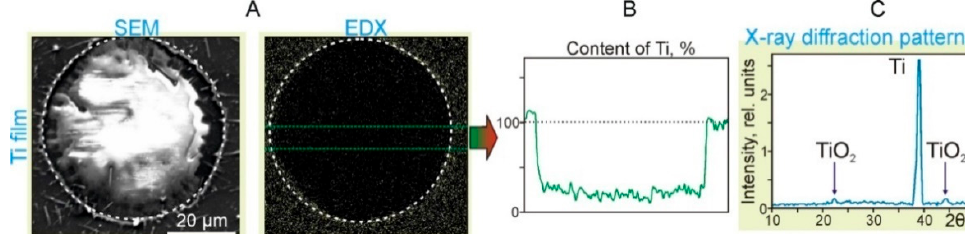
Figure 5. Results of the action of single laser pulses with the energy E = 19.5 mJ and laser fluence F = 2.8 J/cm 2 on the Ti film located in close contact with the sapphire acceptor plate. ( A ) SEM image (SEM) and ( B ) the surface distribution map of titanium particles (EDX). The dotted circles denote an area with the diameter of 54 μ m. ( C ) X-ray diffraction patterns of the Ti film in the region near the dotted circle.